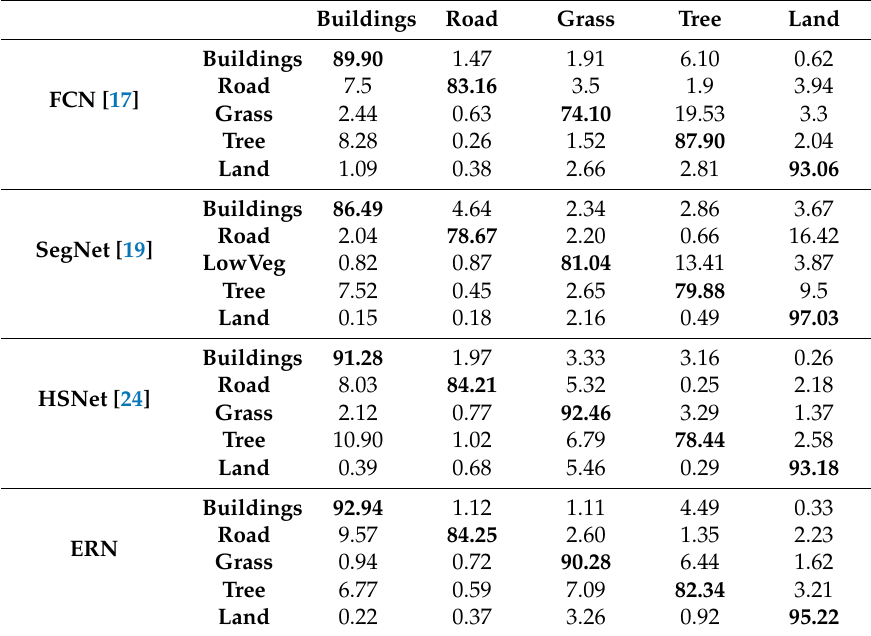
Table A1. Confusion matrix on the UAV Image